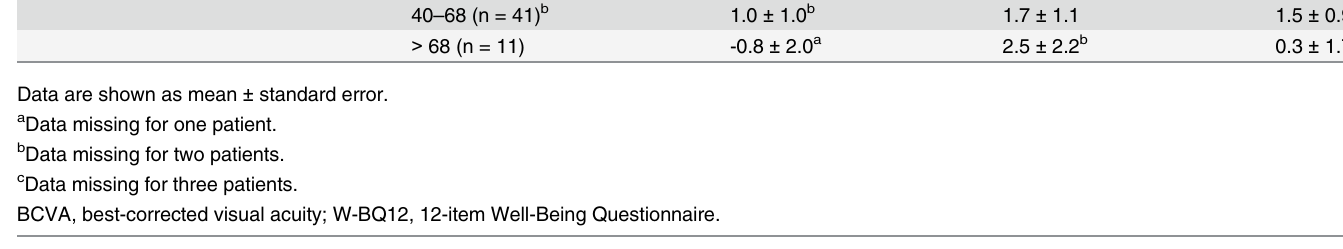
corresponding score increases from baseline to month 12 were 2.1, 0.4 and 0.2. The W-BQ12 negative well-being score decreased by 2.1 from baseline to month 6, and by 1.5 from baseline to month 12, in the BSE subgroup. When the study eye was the WSE, the W-BQ12 negative well-being score decreased from baseline to month 12 by 0.5. W-BQ12 general well-being, en- ergy, and positive well-being scores increased by 1.0, 0.3 and 0.7, respectively, from baseline to month 6 in the WSE subgroup. The corresponding score increases from baseline to month 12 were 1.7, 0.5 and 0.8. higher in patients with a baseline BCVA of 52 letters or fewer than in the other baseline BCVA subgroups, and in patients treated in their WSE rather than in their BSE (S1 Table, available online). There were no statistically significant differences in the change from baseline in W-BQ12 general well-being scores among patients of different ages, although those aged 39 years and younger at baseline had the highest numerical increase from baseline to month 12.